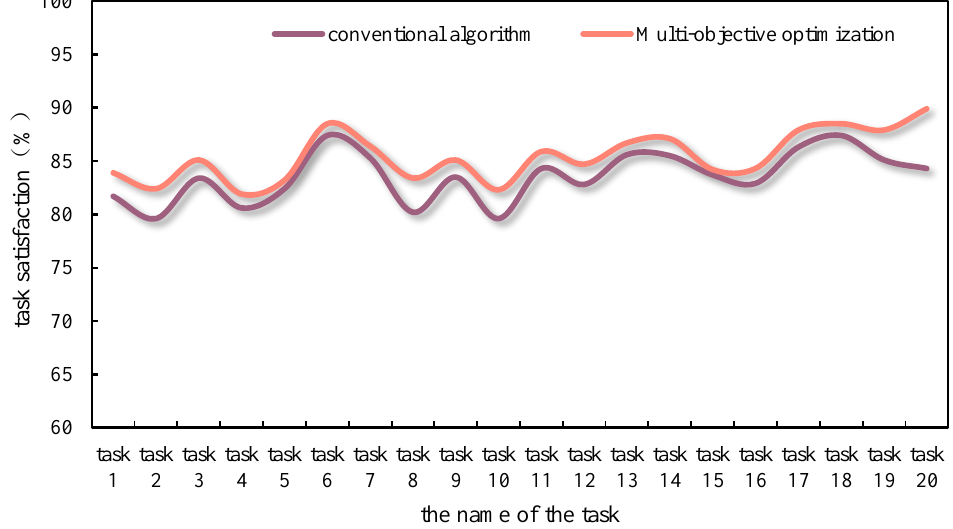
Figure 8. Satisfaction of UAV task completion under two algorithms.